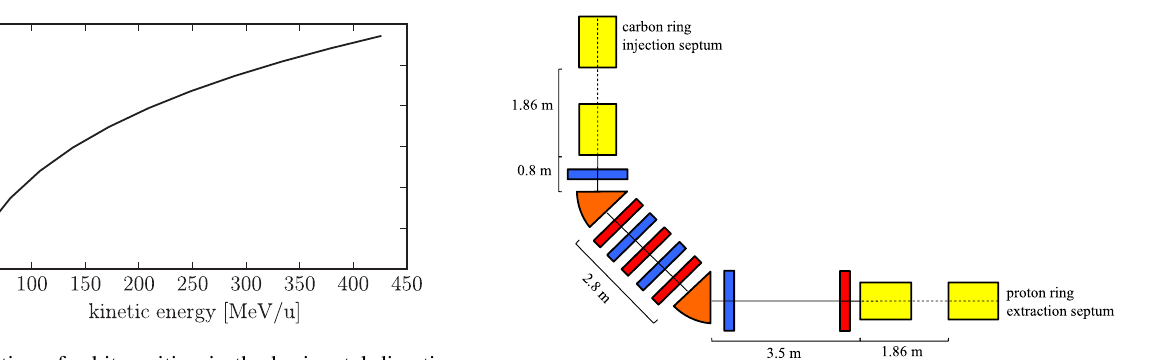
FIG. 12. Variation of orbit position in the horizontal direction during acceleration. FIG. 14. Layout of the matched transfer line for C 6 þ ions from